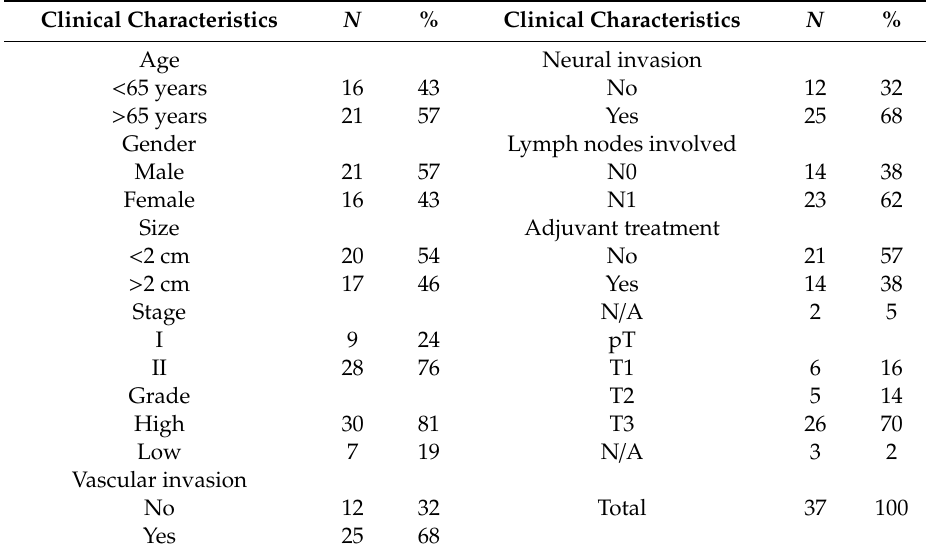
Table 1. Clinico-pathologic characteristics of completed resected R0 pancreatic cancer patients from the training set.